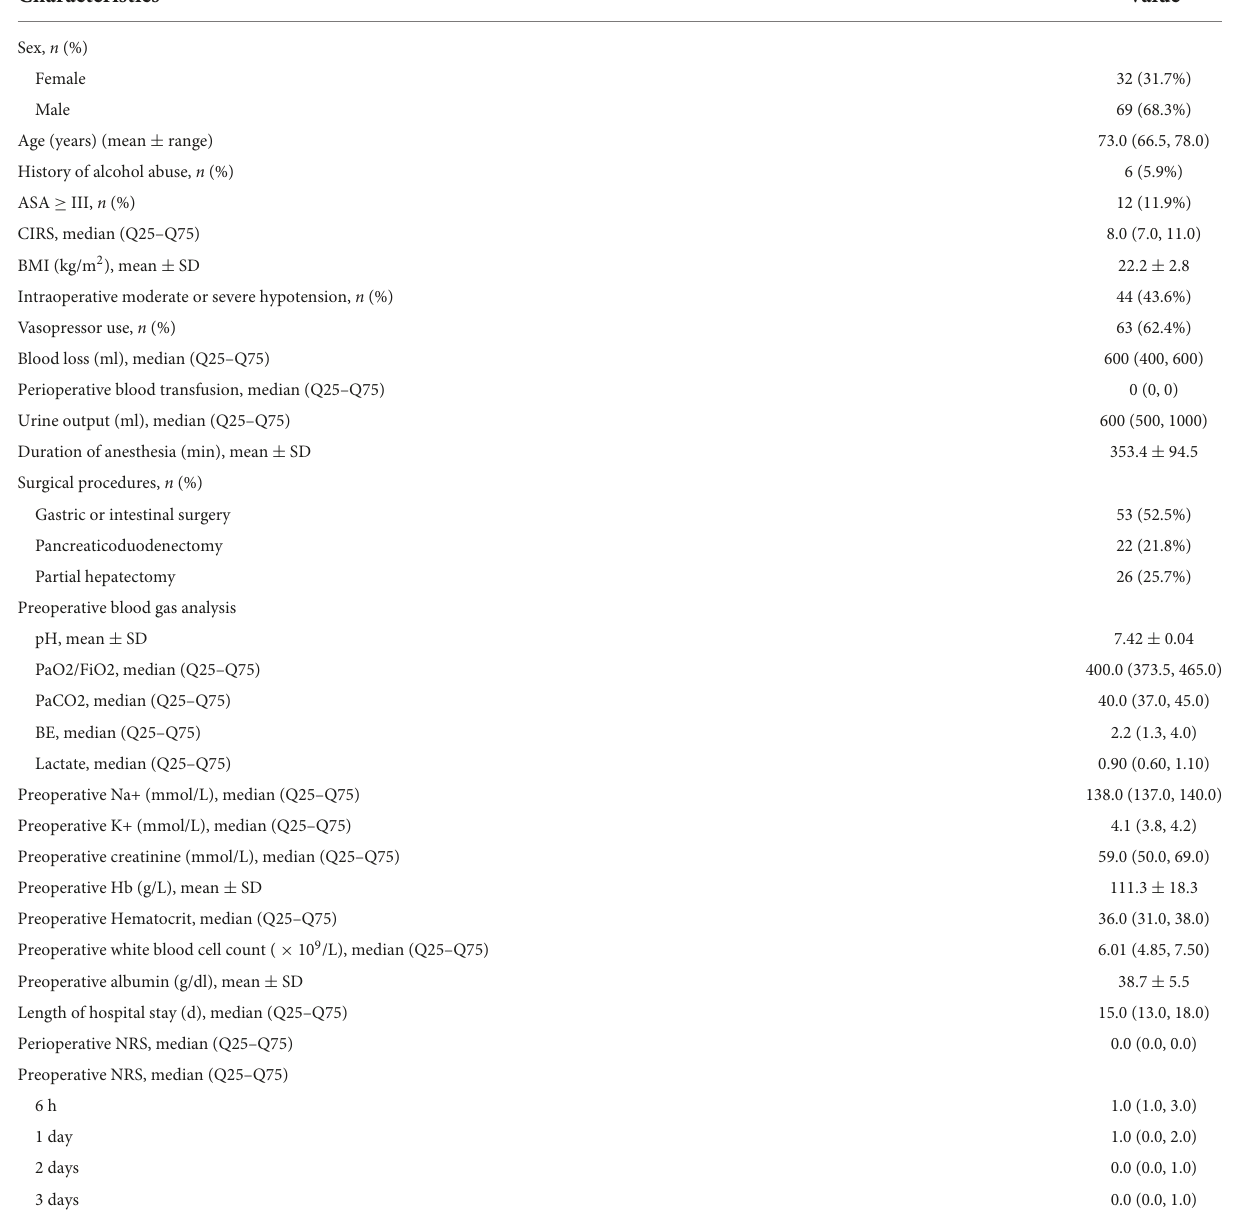
TABLE 1 Baseline characteristics of the 101 included